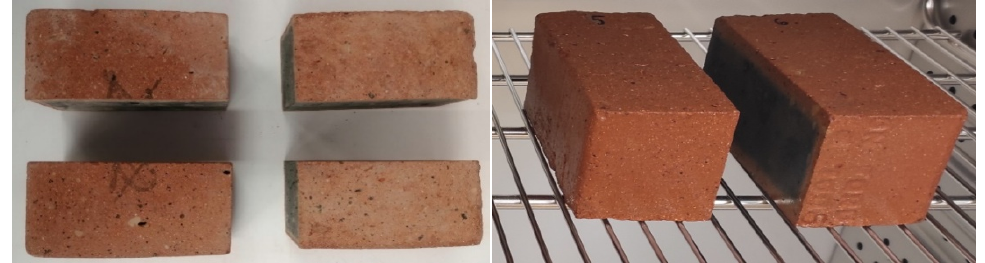
Figure 2. Examples of Group A and B samples prepared for